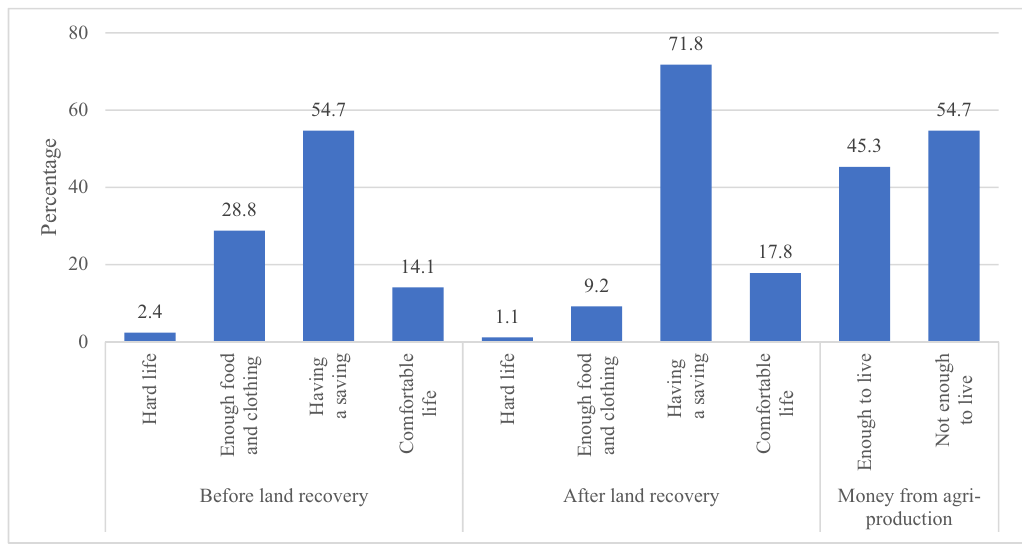
Figure 4: The situation of households ’ life. Source: Households ’ survey ( 2019 )